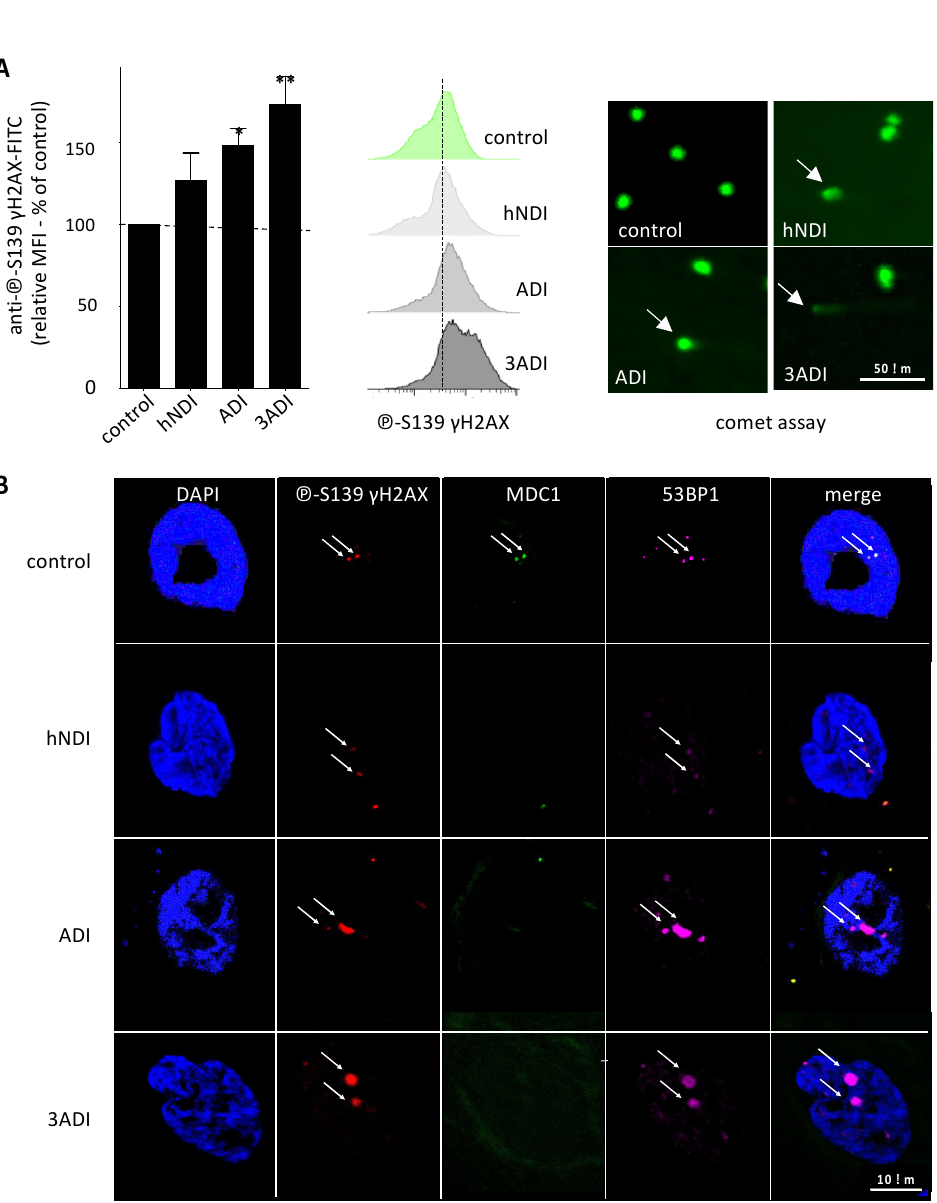
Figure 2. Pesticide exposure for 21 days induces DNA damage in normal BM-MSCs. ( A ) DNA damage with double strand breaks, quantified by ℗ -S139- γ H2AX immunoreactivity by flow cytometry, increases in BM-MSCs after pesticide exposure for 21 days (left panel, n = 6), as shown in a representative experiment (middle panel). Comet assays reveal increased nucleus DNA migration after exposure of BM-MSCs to pesticides for 21 days, as shown in a representative experiment (right panel). ( B ) ℗ -S139 γ H2AX, 53BP1, MDC1 triple immunostaining in BM-MSCs indicates a higher number of double positive 53BP1/ ℗ -S139 γ H2AX signals in the nucleus of exposed cells (FOCI) and a loss of MDC1 staining. Data are expressed as percent of the control ± SEM; *, p < 0.05; **, p < 0.01; Friedman followed by post hoc Dunn’s multiple comparisons test. Scalebar: 50 μ m ( A ) and 10 μ m ( B ).